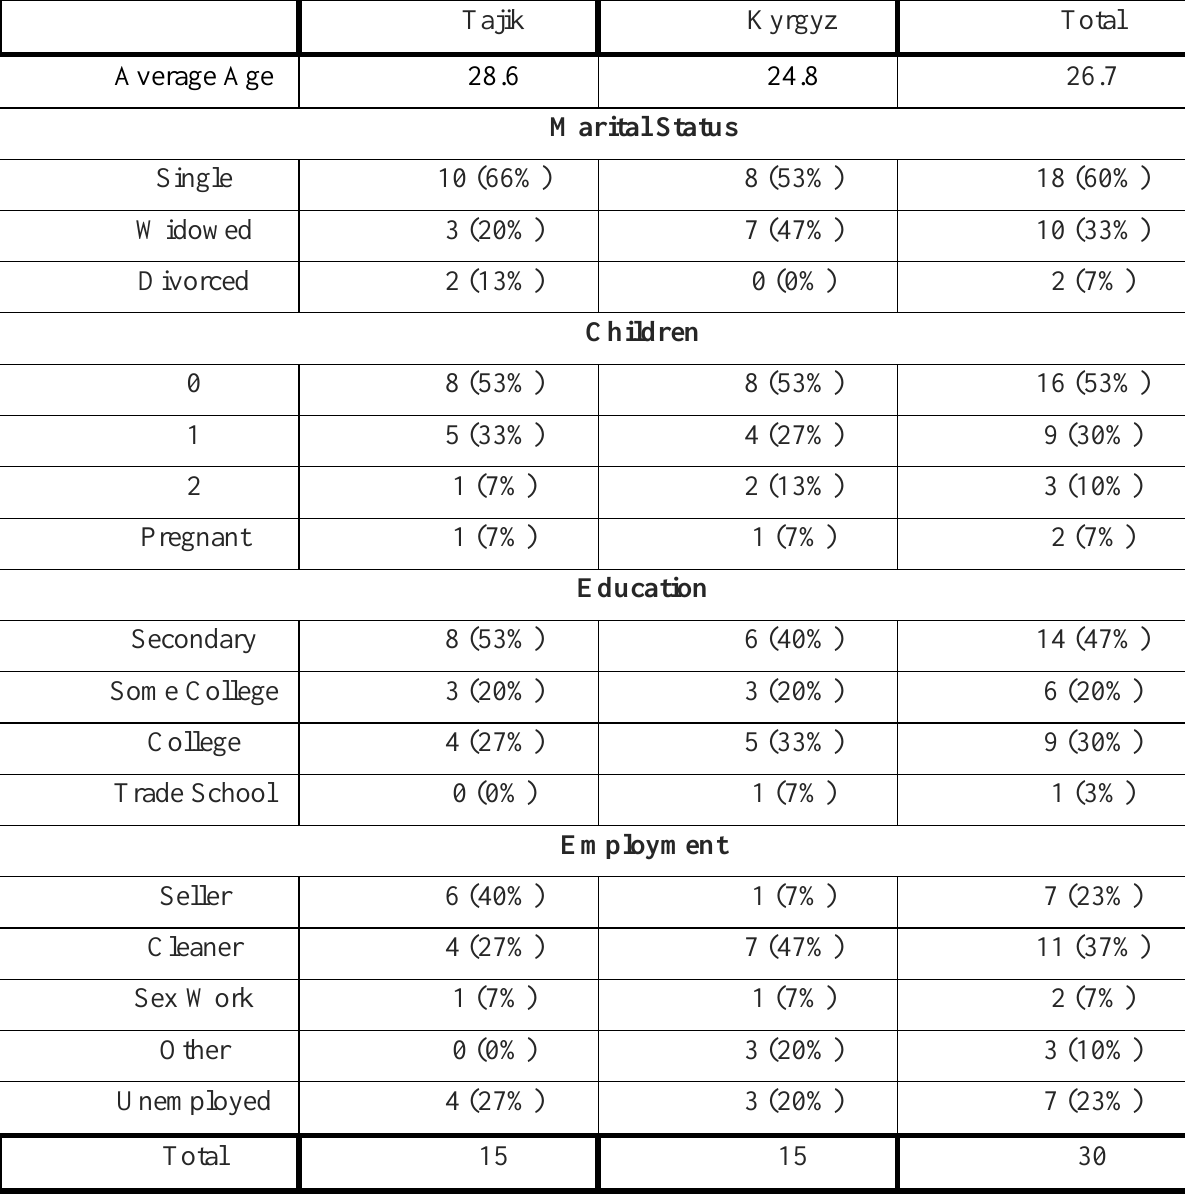
Table 1: Demographic